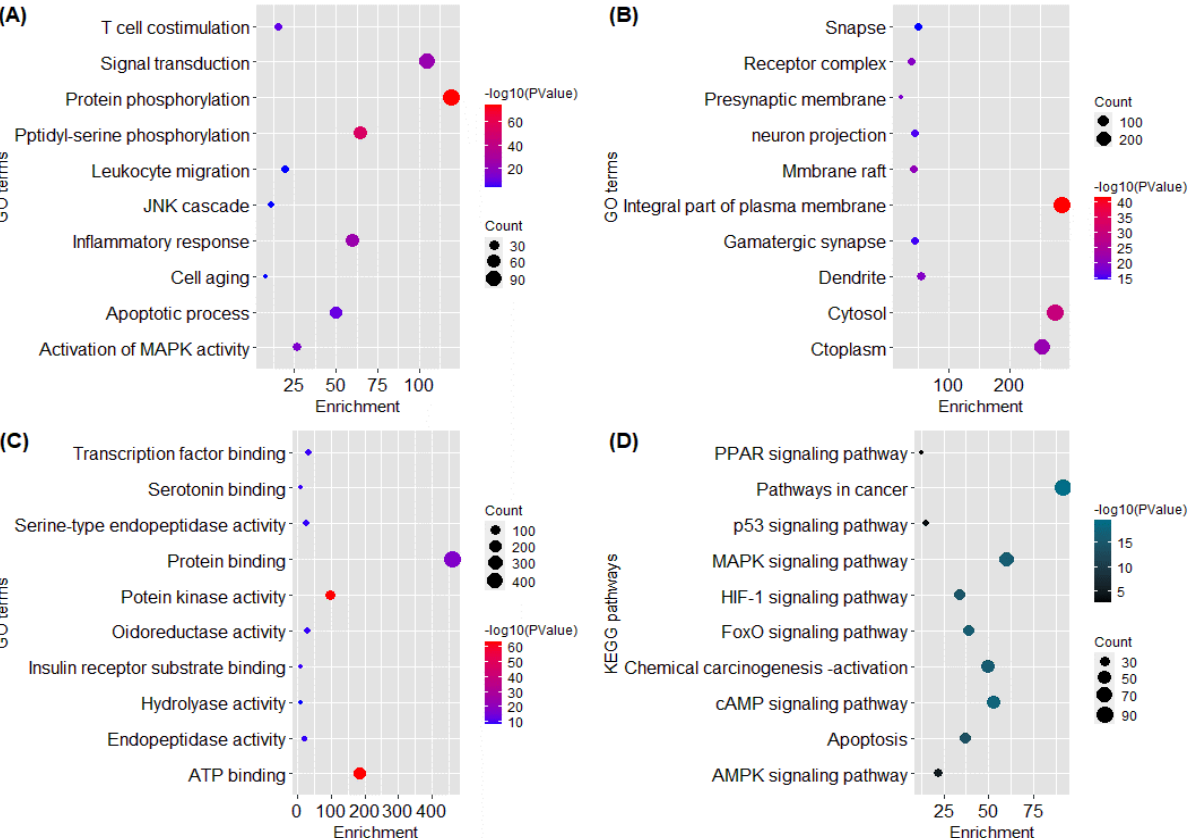
Figure 2. Representation of functional annotation and enriched pathways in form of Bubble Plot. ( A ) GO in terms of biological processes. ( B ) GO in terms of molecular function. ( C ) GO in terms of cellular components. ( D ) KEGG pathway analysis.